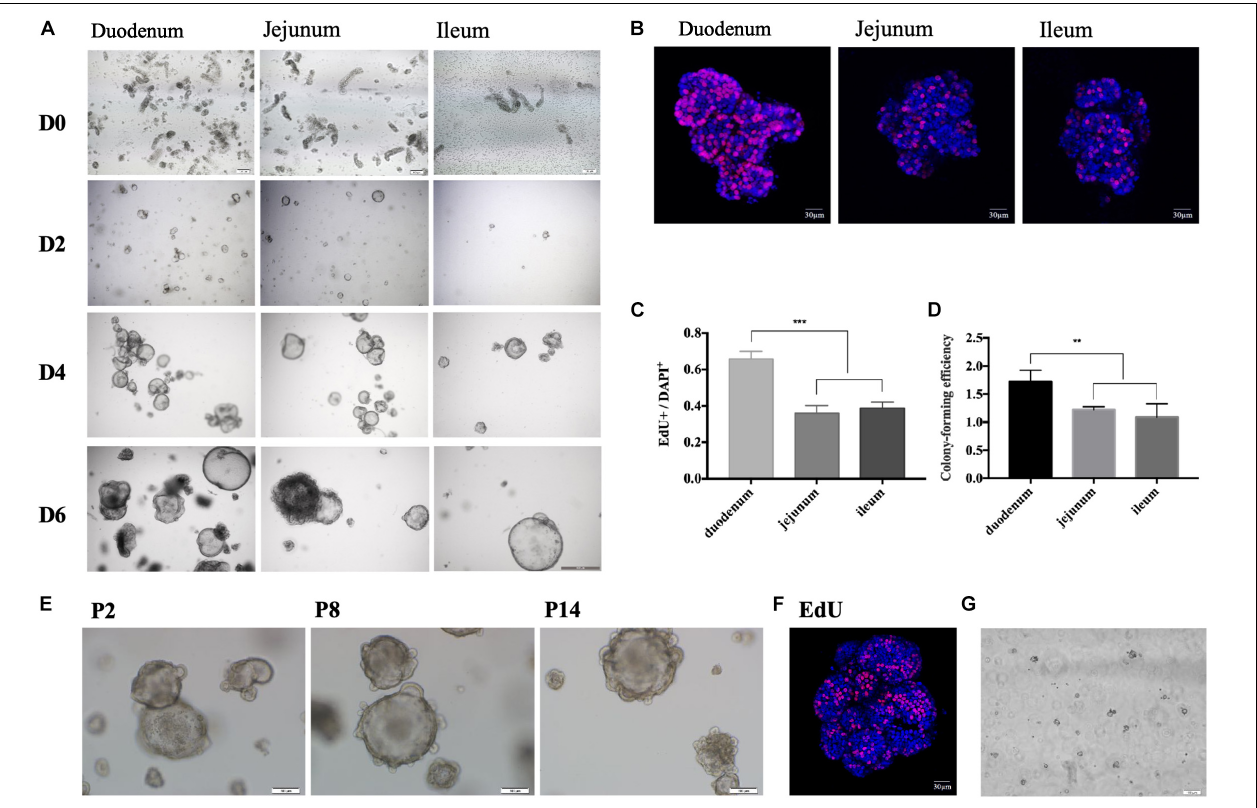
FIGURE 2 | Growing 3-D porcine intestinal enteroids. (A) The time course of development of undifferentiated porcine duodenum (left) , jejunum (middle) , and ileum (right) enteroids. (Scale bar = 100 µ m). (B) EdU staining of the enteroids from duodenum, jejunal, and ileum after 6-day growth (Scale bar = 5 µ m). (C) The proportion of EdU positive cells in duodenum ( n = 10), jejunum ( n = 12), and ileum ( n = 9) enteroids. (D) Comparison of the colony-forming efficiency at day 7 of the enteroids from duodenum, jejunum, and ileum. (E) Representative morphological images of jejunal enteroids under different generations (Scale bar = 100 µ m). (F) The 14th generation enteroids freshly stained with EdU (red) (Scale bar = 100 µ m). (G) Morphology of jejunal enteroids at day 2 after cell resuscitation (Scale bar = 100 µ m). (* p < 0.05, ** p < 0.01, and *** p <